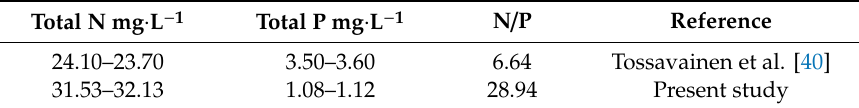
Table 2. Initial nutrient concentration in algal